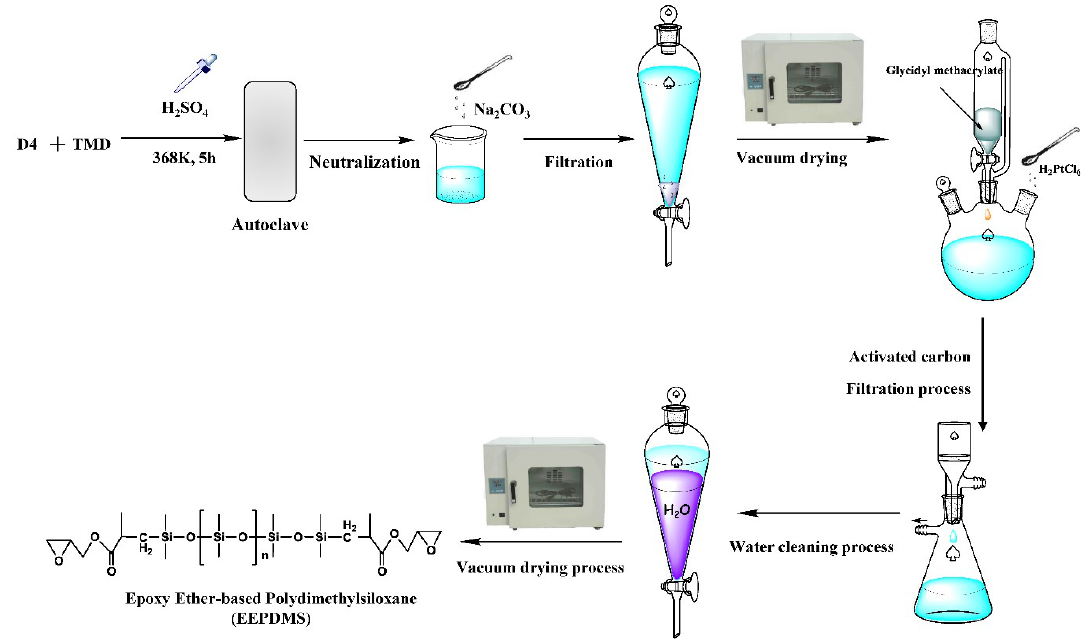
Figure 1. The synthesis process of